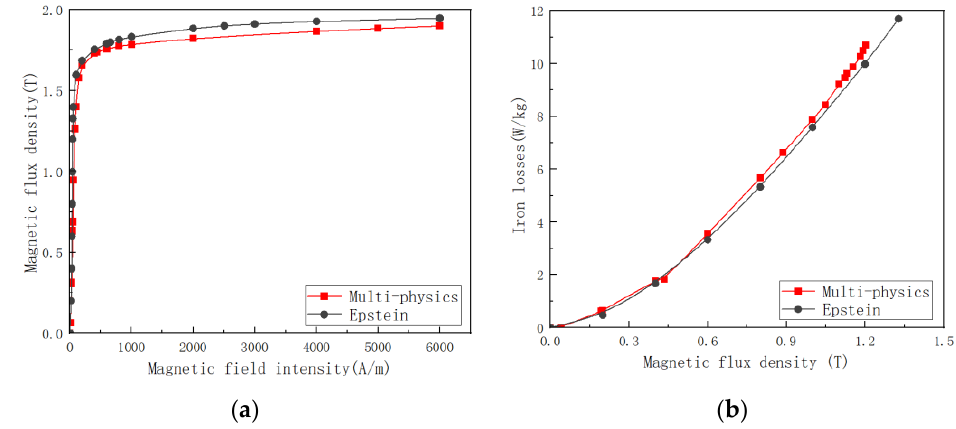
Figure 15. Comparison of magnetic properties of grain-oriented silicon steel under multi-physical field coupling and conventional measurements. ( a ) magnetization curves of H-80 material @75 ◦ C, 75 Mpa and 400 Hz. ( b ) iron loss curves of H-80 material at different angles @@75 ◦ C, 75 Mpa and 400